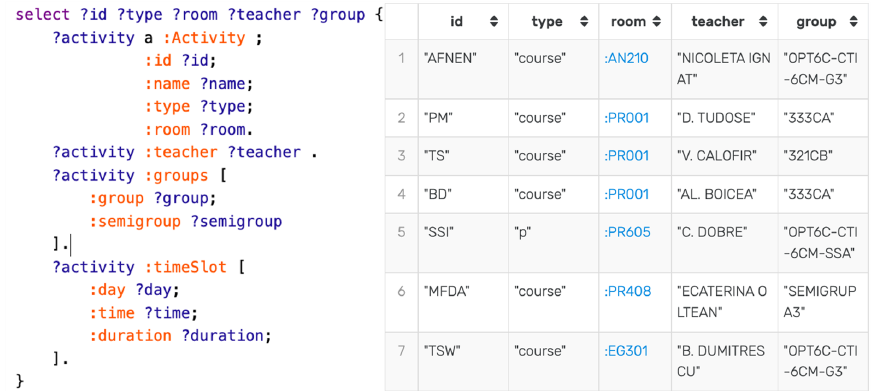
Figure 5. Query and response for timetable activity extraction